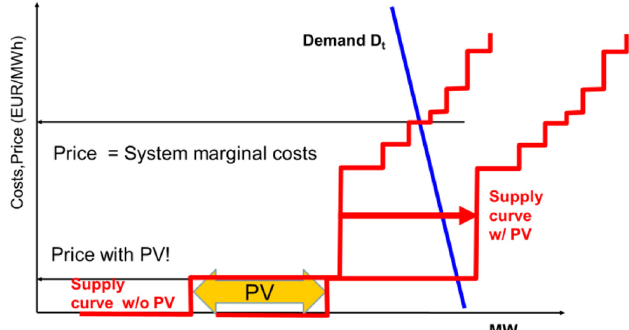
Fig. 2. Merit order electricity supply curve including and excluding signi fi cant PV quantities at noon on a sunny day in summer and the additional marginal costs for nuclear, coal and natural